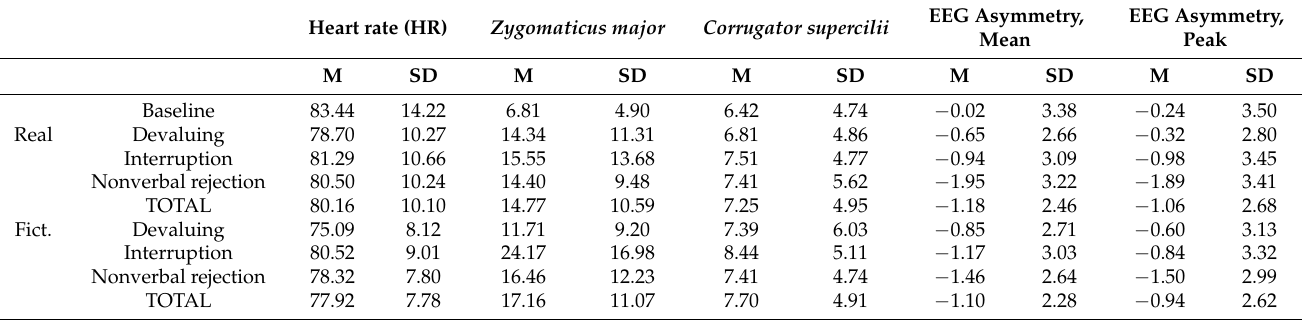
Table A1. Baseline Values and Social Rejection Responses (HR, Facial EMG and EEG Asymmetry).